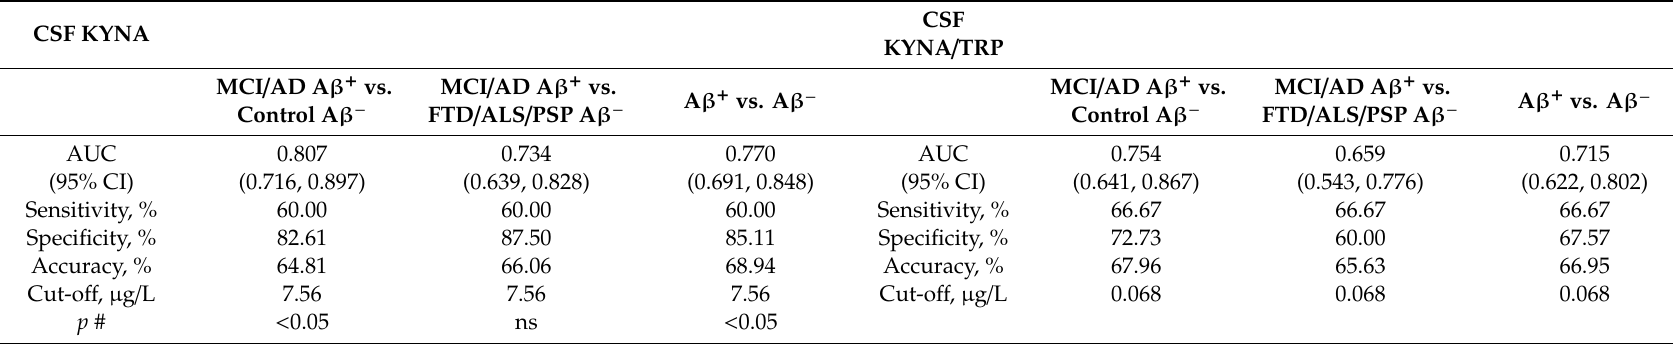
Table 2. Diagnostic accuracy of KYNA and KYNA / TRP in